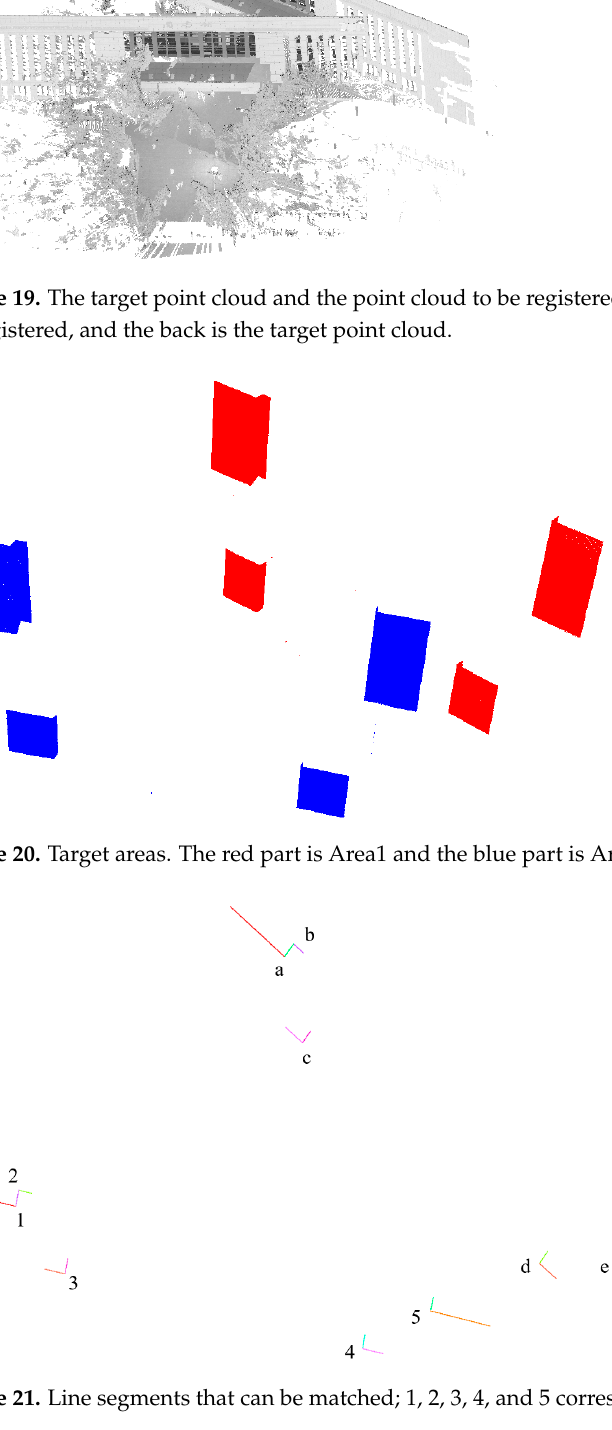
Figure 22. Two-dimensional projection line segments after registration on the X-Y plane. ( a ) ( b ) Figure 23. The registered point cloud on the X-Y plane. ( a ) Top view. ( b ) Front view. However, as shown in Figure 23b, the two registered point clouds still have elevation deviation in the Z direction. It is known that the average ground elevation near the scan- ner of P t and P s is − 175.084 m and − 180.901 m, respectively. The final registration result can be obtained by shifting P s upward by 5.817 m (see Figure 24).